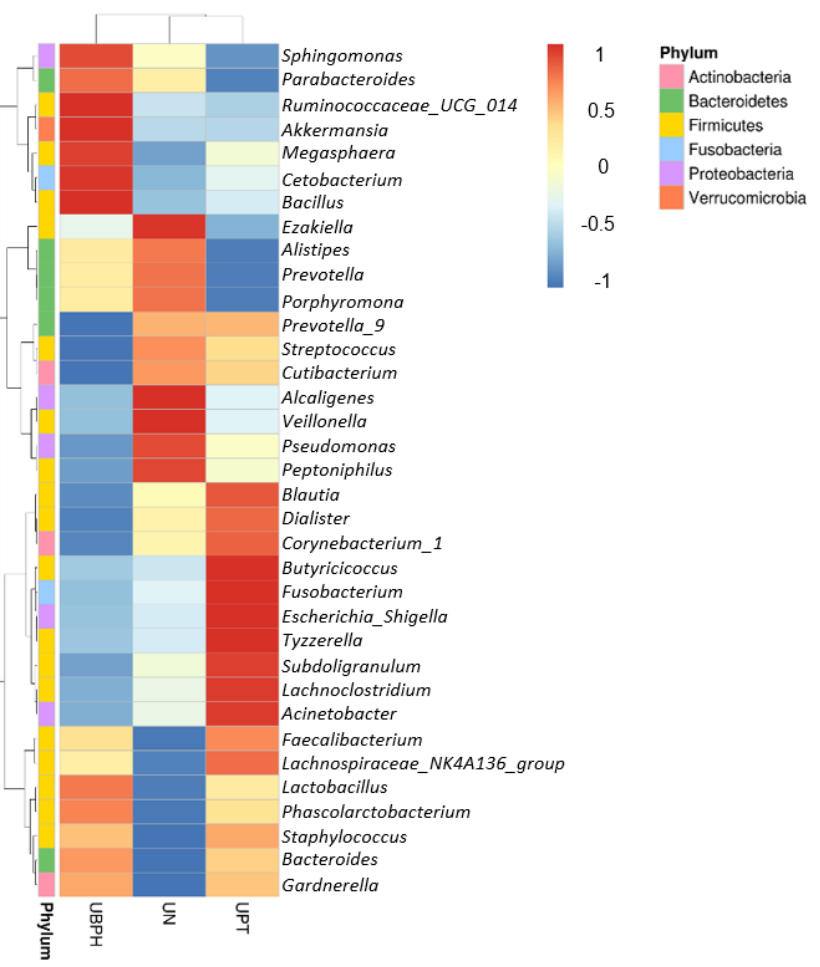
Figure 5. Genus heat map lists down the top 35 genera identified in urine sample. The z-score of each genus abundance in each group is shown in different color. The z-score is computed on a genus-by-genus (row-by-row) basis by subtracting the mean and then dividing by the standard deviation. The right upper -1–1 color bar stands for standardized z-score. UBPH stands for patients with BPH. UN stands for control group. UPT stands for patients with prostate cancer.